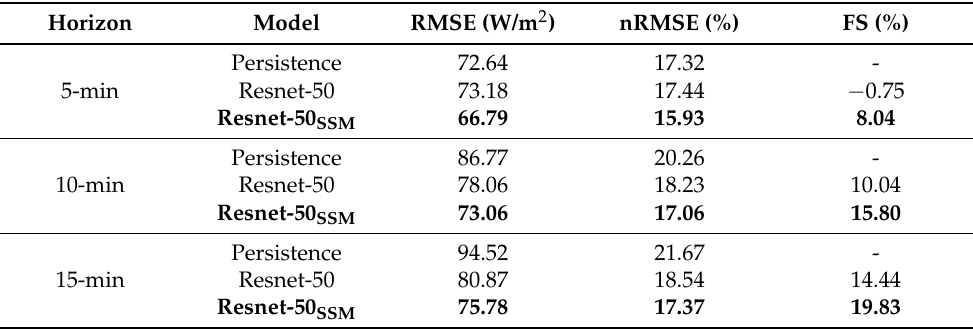
Table 3. Standalone irradiance forecasting results for the ResNet-50 model on 5, 10, and 15 min horizons. SSM indicates that the input is three stacked images of four channels each (i.e., RGB and SunMask) and the improved results are highlighted in